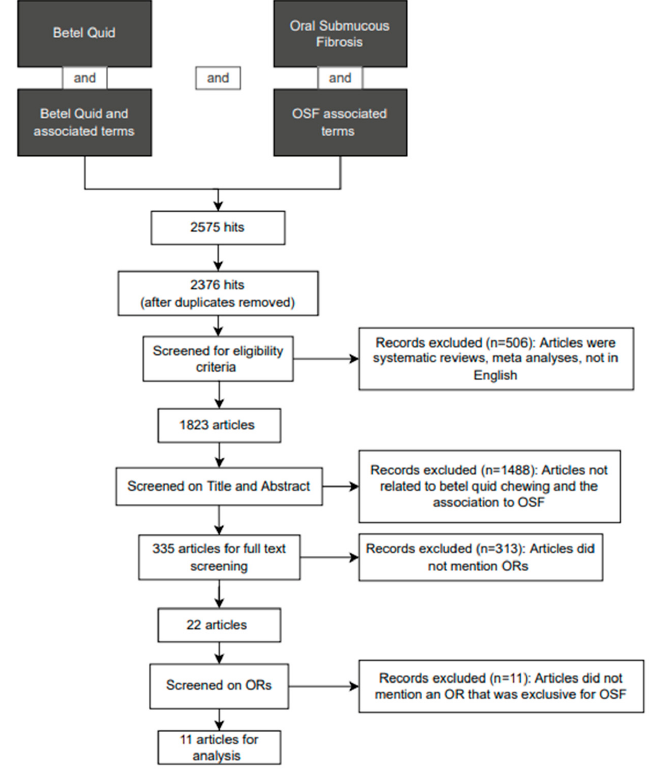
Figure 1. Flow chart of the selection process according to PRISMA guidelines. PRISMA, Preferred Reporting Items for Systematic Reviews and Meta-Analysis. Of the remaining 22 articles, 11 papers were excluded because they reported ORs that were not exclusive to OSF; the remaining 11 papers were deemed to be eligible for detailed assessment (Figure 1). An overview of the BQ mixtures and their association with OSF is shown in Table 2. The number of participants in the included studies ranged from 102 to 49,085 with median 1007. ‘Unspecified’ is used to denote BQ mixtures where the exact components of the BQ were not specified in the article. The relationship between BQ and additives to OSF risk is shown in Figure 2. Table 2. Overview of articles that were eligible for analysis. Typical betel quid ingredients, when present in the mixture, are labeled with “X”.